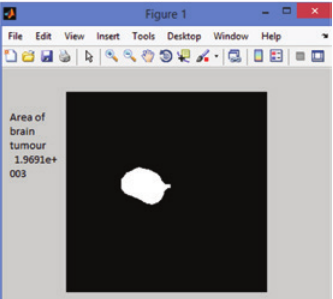
Figure 6: Extraction of Tumour for Real CT Scan Brain Medical Image Using MATLAB.